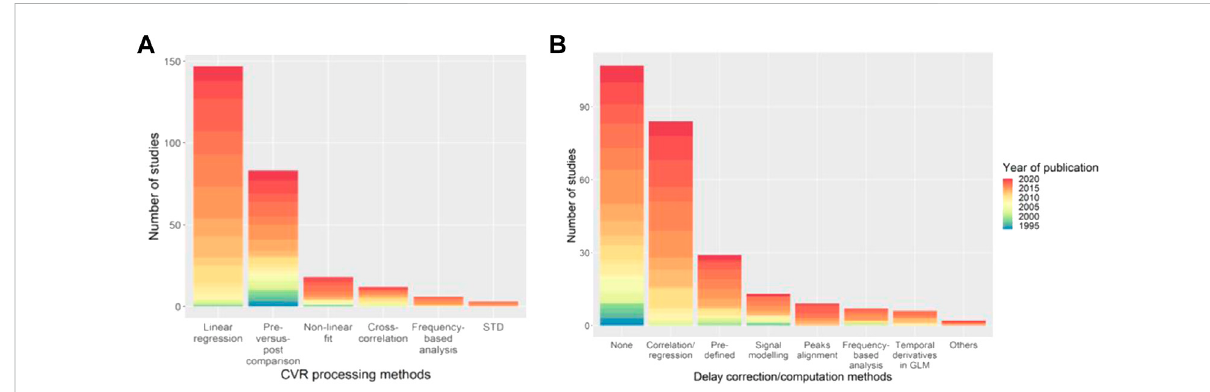
FIGURE 5 Distribution of the (A) CVR processing and (B) delay computation methods with the associated year of publication of the paper. The category “ Others ” in (B) includes deconvolution to fi nd the HRF between the EtCO standard deviation of MRI signal; HRF, haemodynamic response function; GLM, general linear